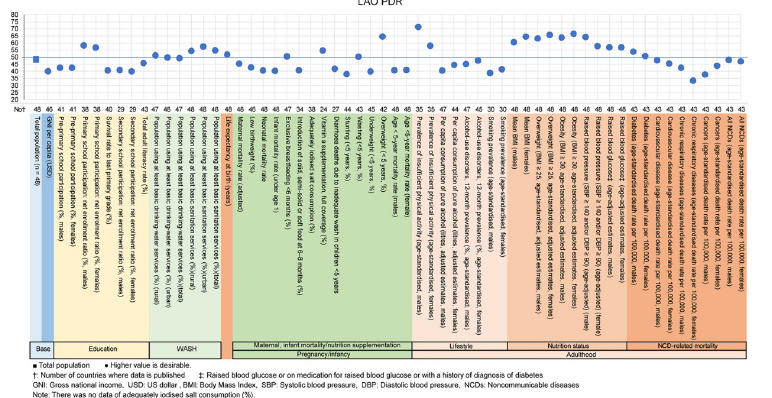
Fig 3. Country diagnosis by the deviation graph for Lao People’s Democratic Republic (Lao PDR).